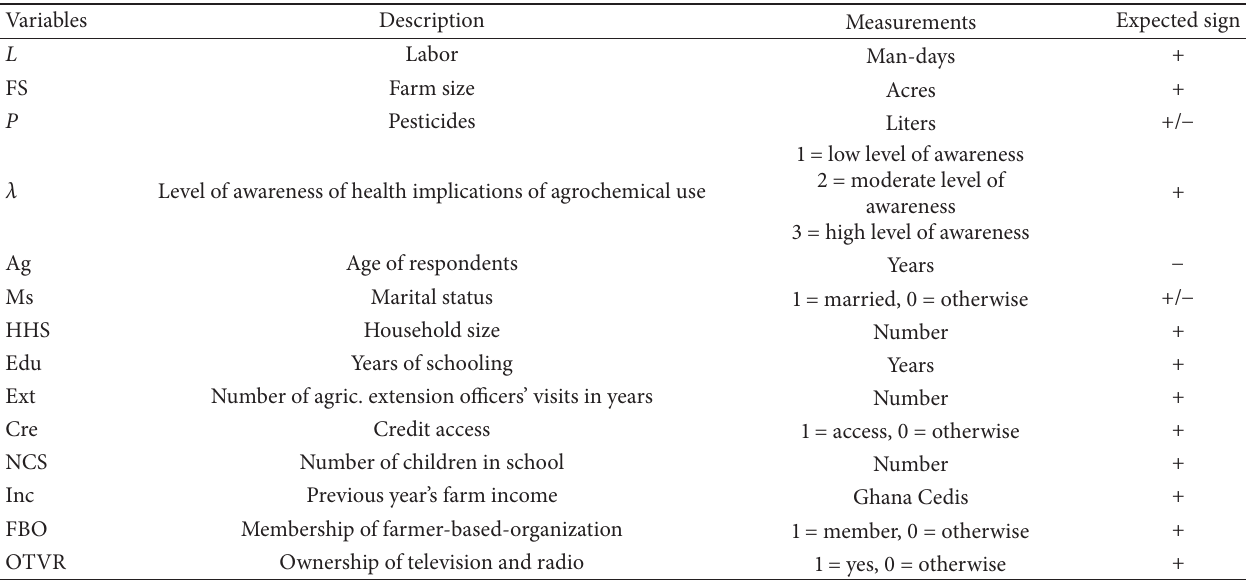
Table 2: Definitions and measurements of variables included in the